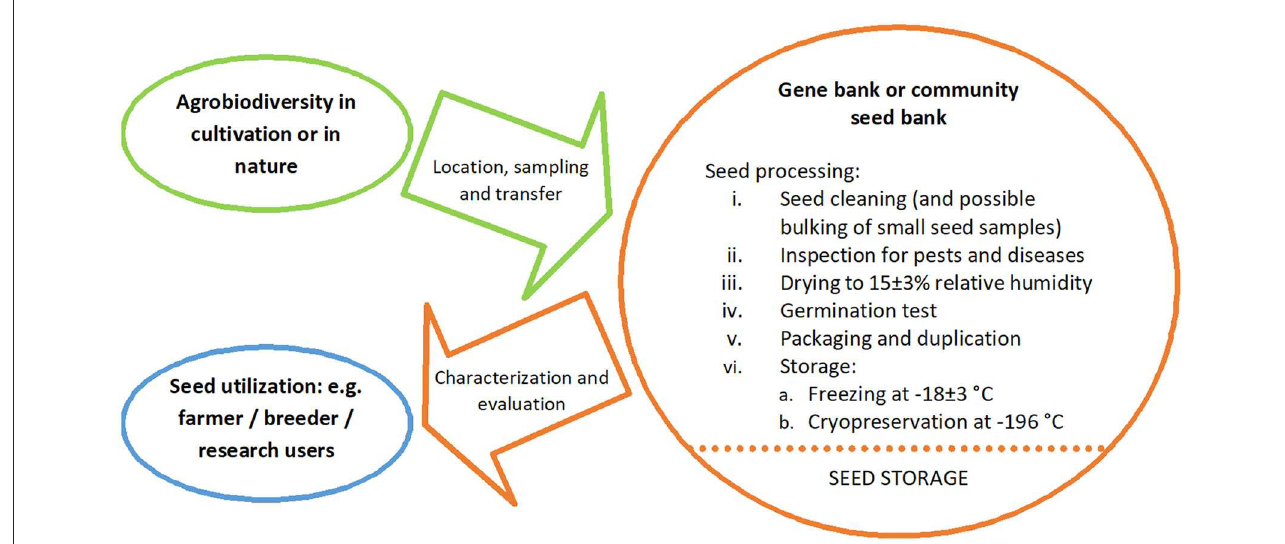
FIGURE2 Key elements of gene bank conservation (Maxted et al.,